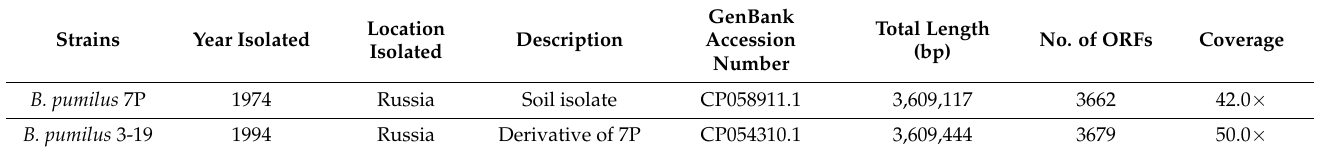
Table 1. Characteristics of B. pumilus 7P and 3-19 strains. Genome assembly and annotation statistics of both